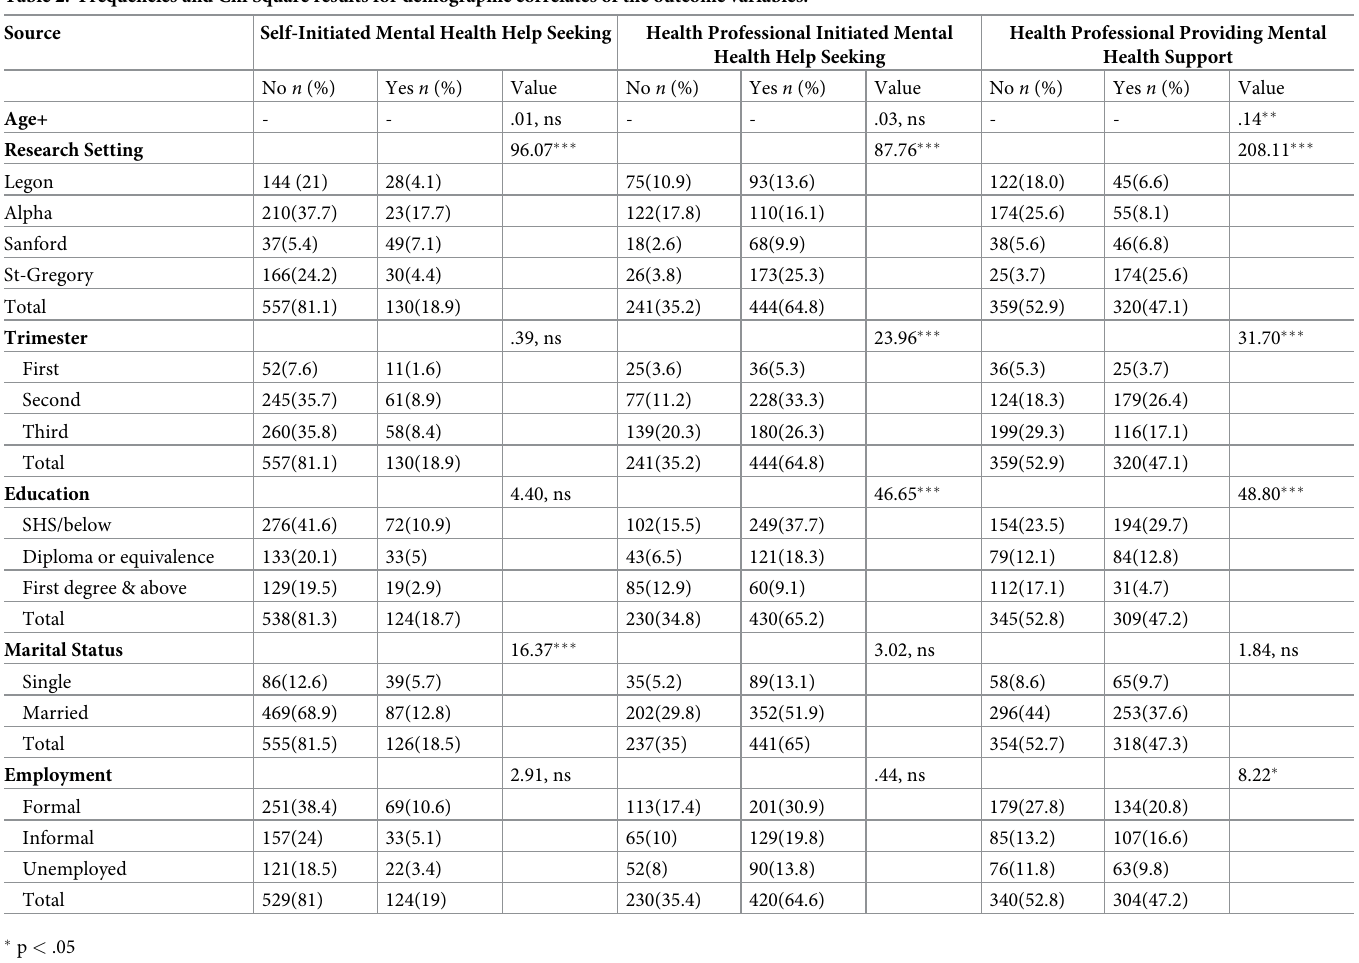
Table 2. Frequencies and Chi Square results for demographic correlates of the outcome